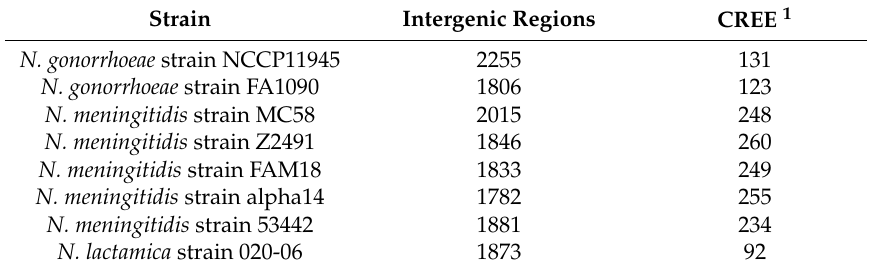
Table 2. Number of Correia Repeat Enclosed Elements in Neisseria spp. genome